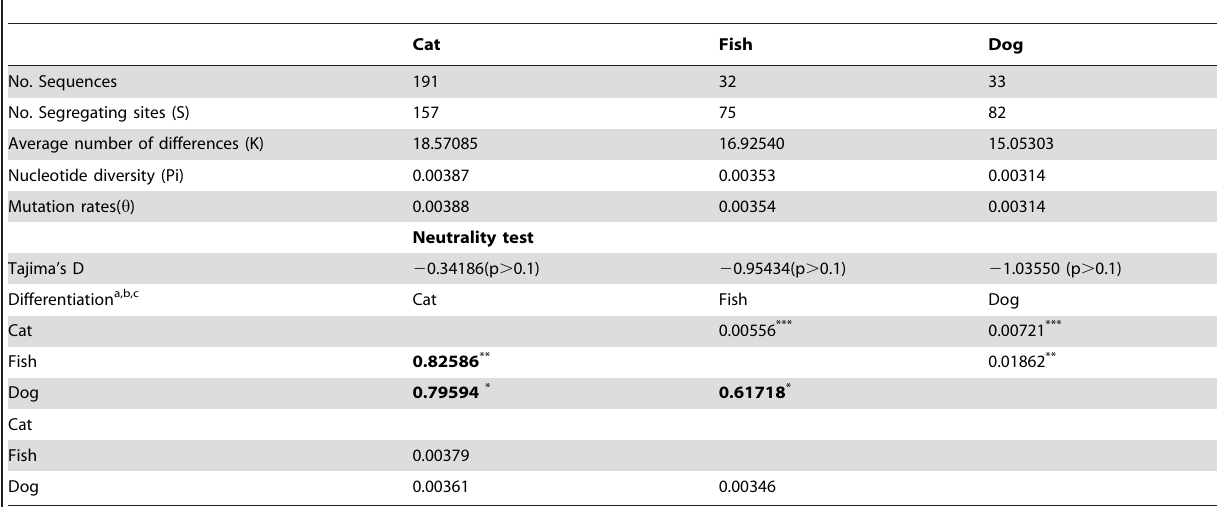
a K ST values are displayed above the diagonal and represent the weighted measure of the ratio of the average pair-wise differences within groups to the total average pair-wise differences. b S nn values are displayed below the diagonal in bold and represent the proportion of nearest neighbors in sequence space that are found in the same group. Significance levels for K ST and S nn were assessed using permutation tests, with 1000 permutations: ns=non-significant, * 0.01 , p , 0.05. ** 0.001 , p , 0.01, *** p , 0.001. c Dxy values are displayed at the bottom of the diagonal and represent the minimum estimate of the number of nucleotide differences per site between groups.